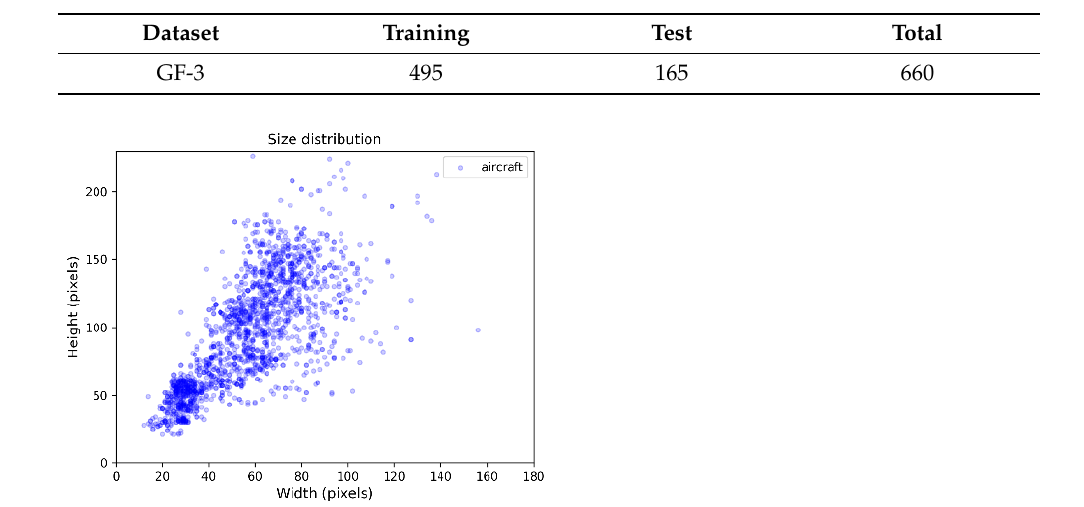
Table 1. Detailed information on the experimental dataset.